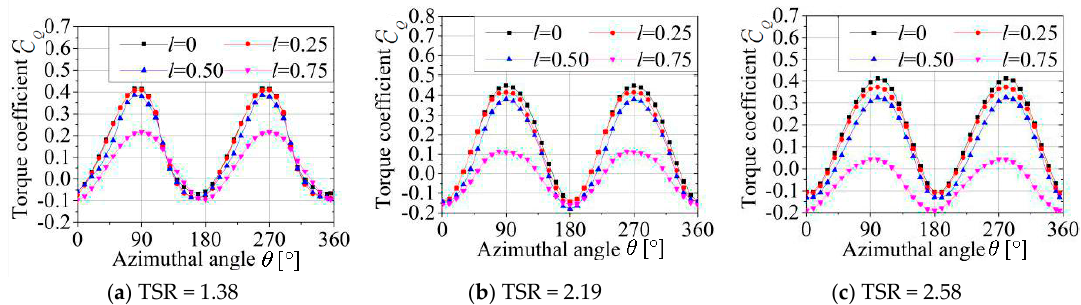
Figure 13. Fluctuation of torque coefficient in the spanwise cross-sections of l = 0, 0.25, 0.50 and 0.75 for rotor at a rotation period at the three different TSRs (TSRs = 1.38, 2.19 and 2.58): ( a – d ) show the wind velocity deficits of l =0, 0.25, 0.5 and 0.75, respectively.